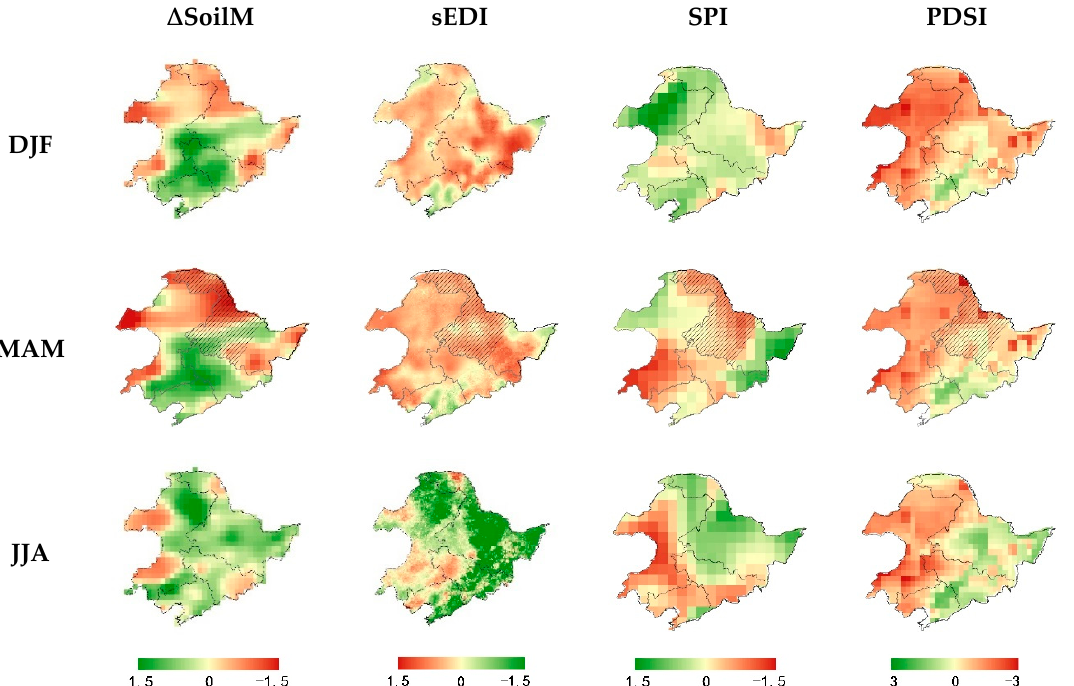
Figure 6. Seasonal standardized anomalies in SoilM, EDI, SPI, and PDSI from December 2005 to August 2006. Green indicates wetness and red indicates dryness. The dashed line refers approximately to a recorded dry patch.